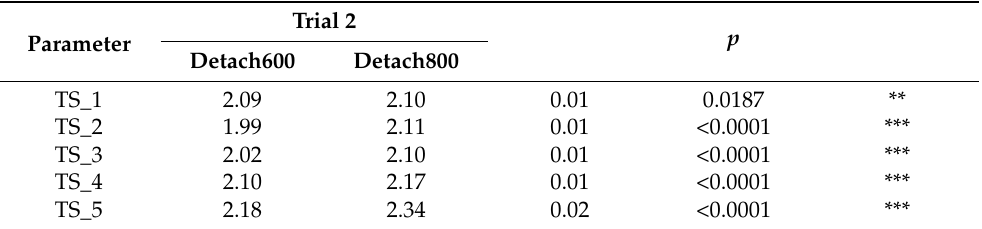
Table 7. Least-square means (LSM), standard error (S.E.), and statistical difference ( p -value) of the teat-end scores (TS-1 to TS-5) in chronological order for Trial